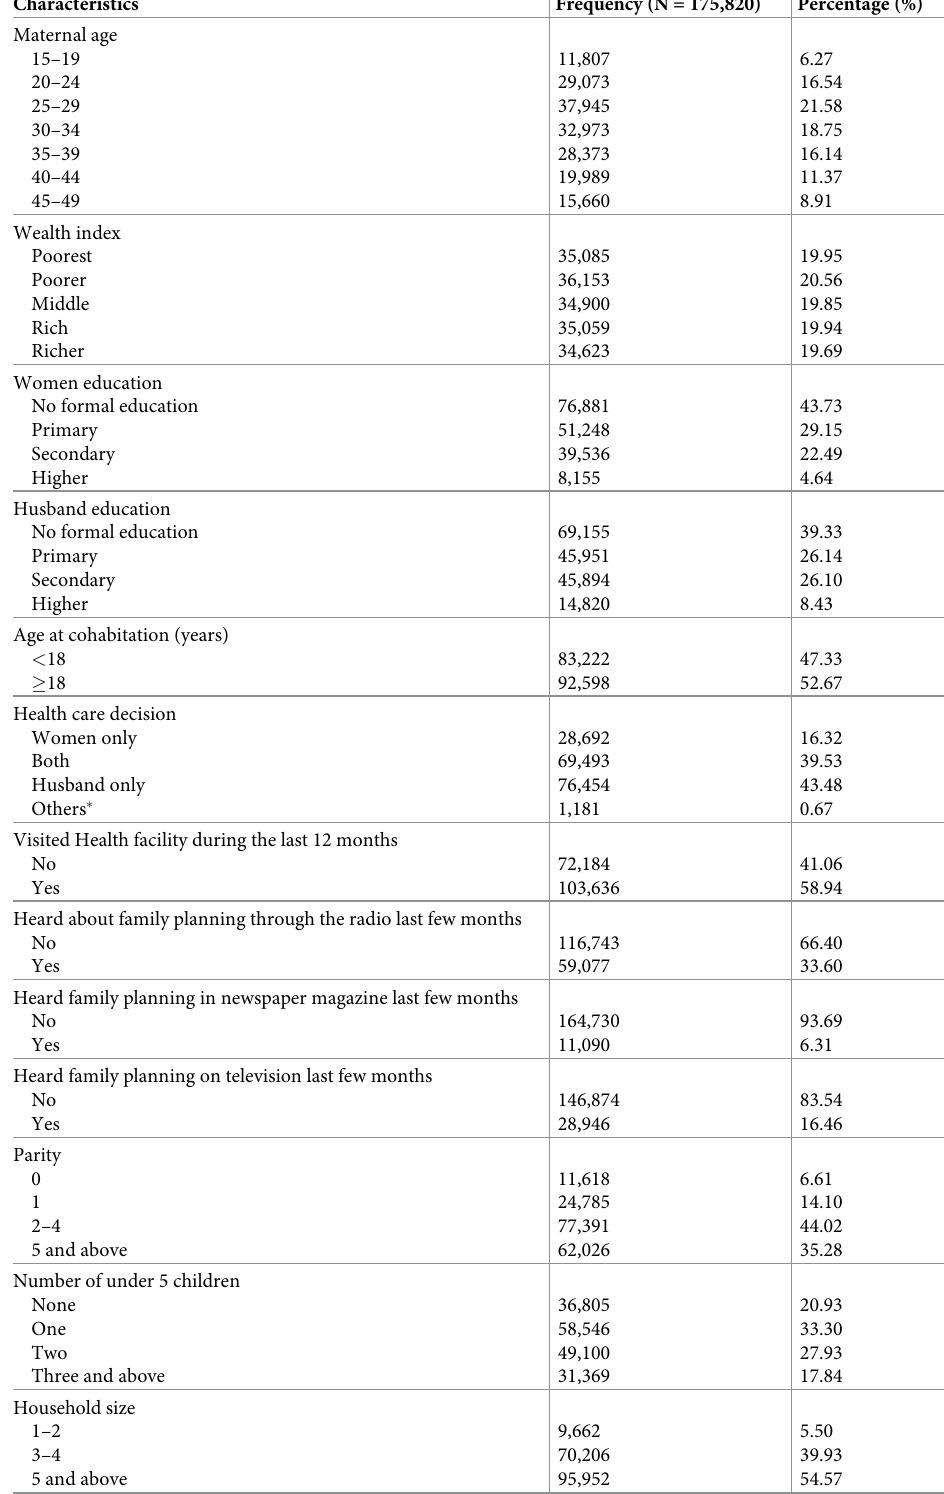
Table 2. Sociodemographic characteristics of respondents and their